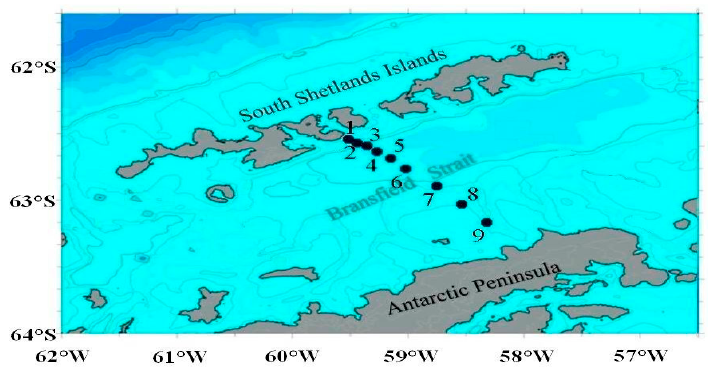
Figure 5. Location of bioluminescence stations in the Bransfield Strait.